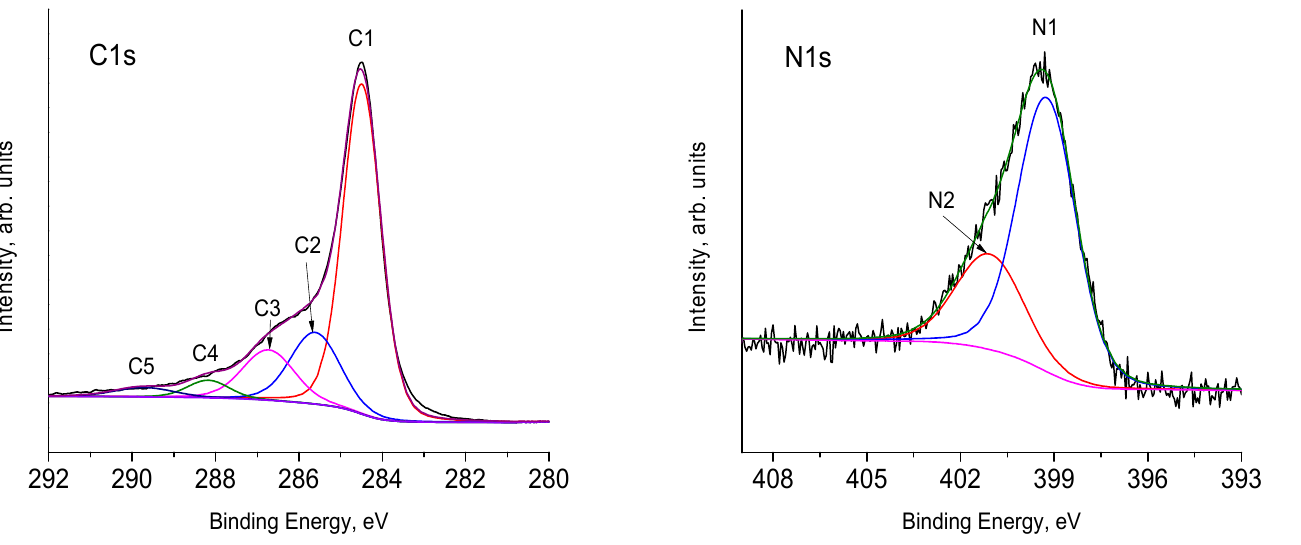
Figure 3. High-resolution XPS spectra of C1s and N1s of the nanocomposites containing 15 mass % TiO 2 . Table 1. Position and intensity of C1s peaks.